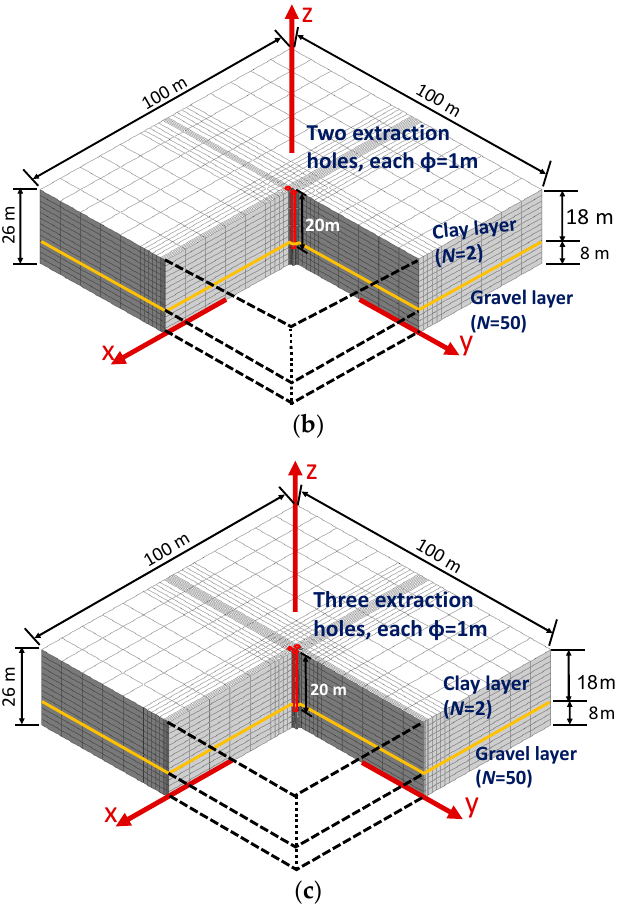
Figure 1. Analysis of cross-section on ground with extraction holes of removed piles; ( a ) case with one extraction hole of removed pile; ( b ) case with two extraction holes of removed piles; ( c ) case with three extraction holes of removed piles.